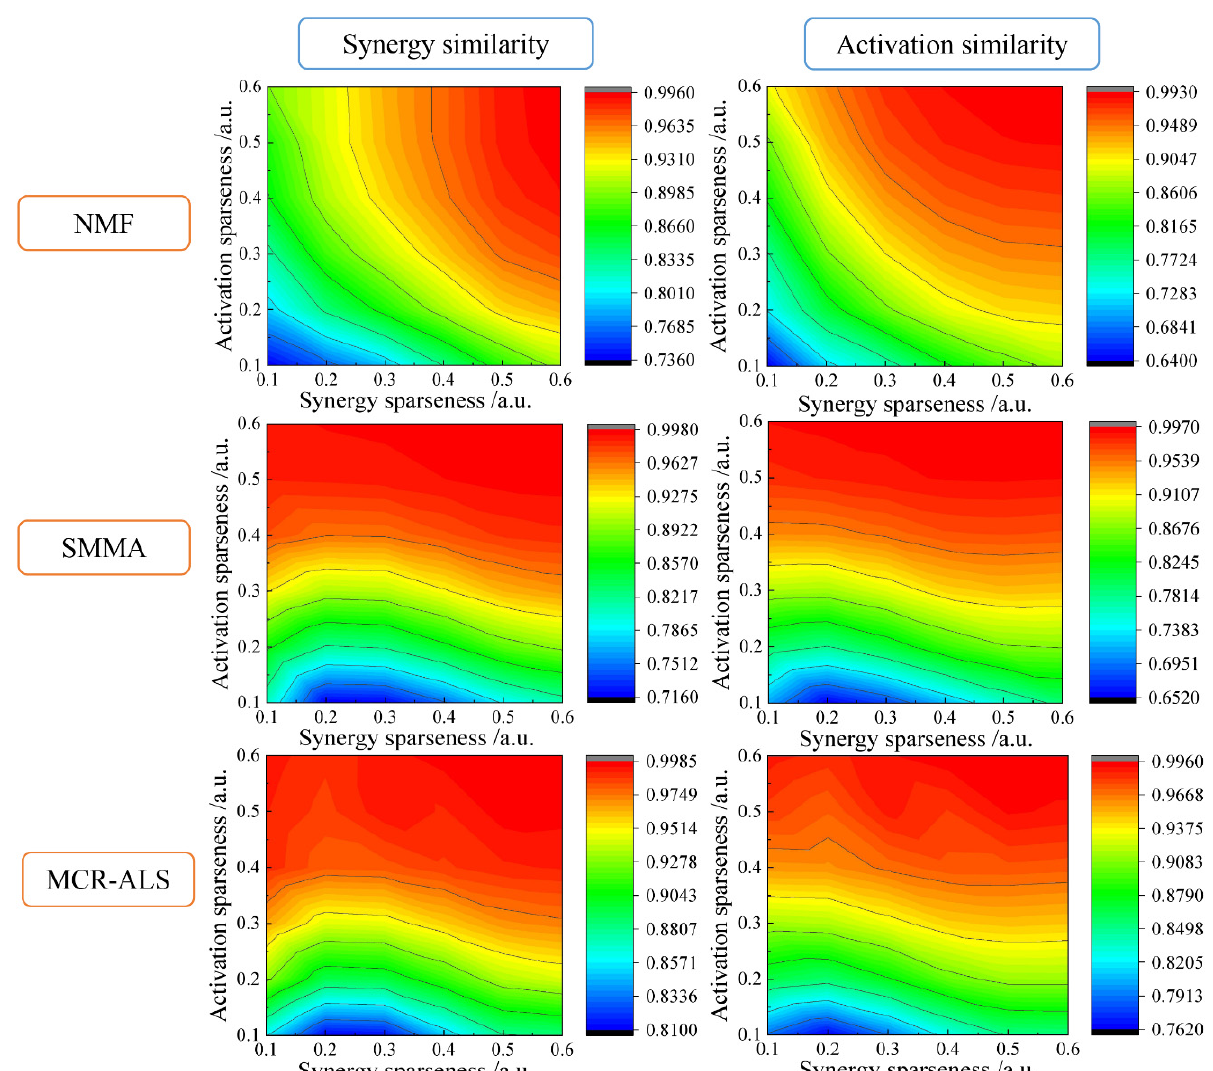
Figure 3. The performances of NMF, SMMA, and MCR-ALS versus synergy sparseness and activation sparseness under the circumstance of noise level 0.05. (The color represents the degree of similarity evaluated by the Pearson’s correlation coefficient between the synergies and activations extracted by the matrix decomposition algorithms and the true synergies and activations; the isolines represent the same value of average correlation coefficients; a.u. represents arbitrary unit) .